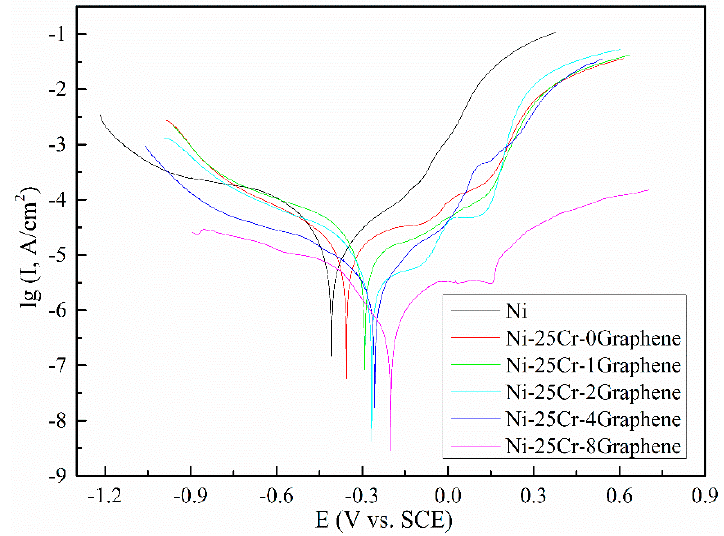
Figure 13. Potentiodynamic polarization curves of the Ni–Cr–graphene coatings in 3.5% NaCl solution. Table 2. Corrosion characteristics of the Ni–Cr–graphene coatings in 3.5% NaCl solution.